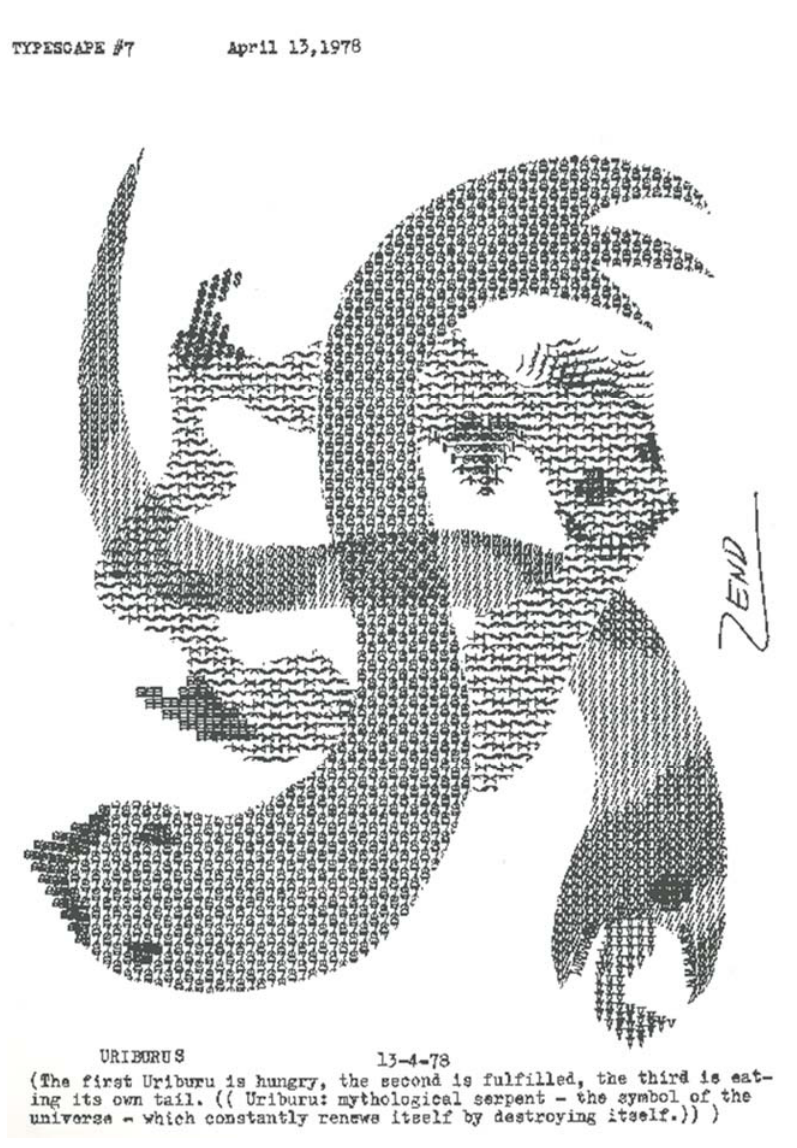
Figure 3. “Typescript